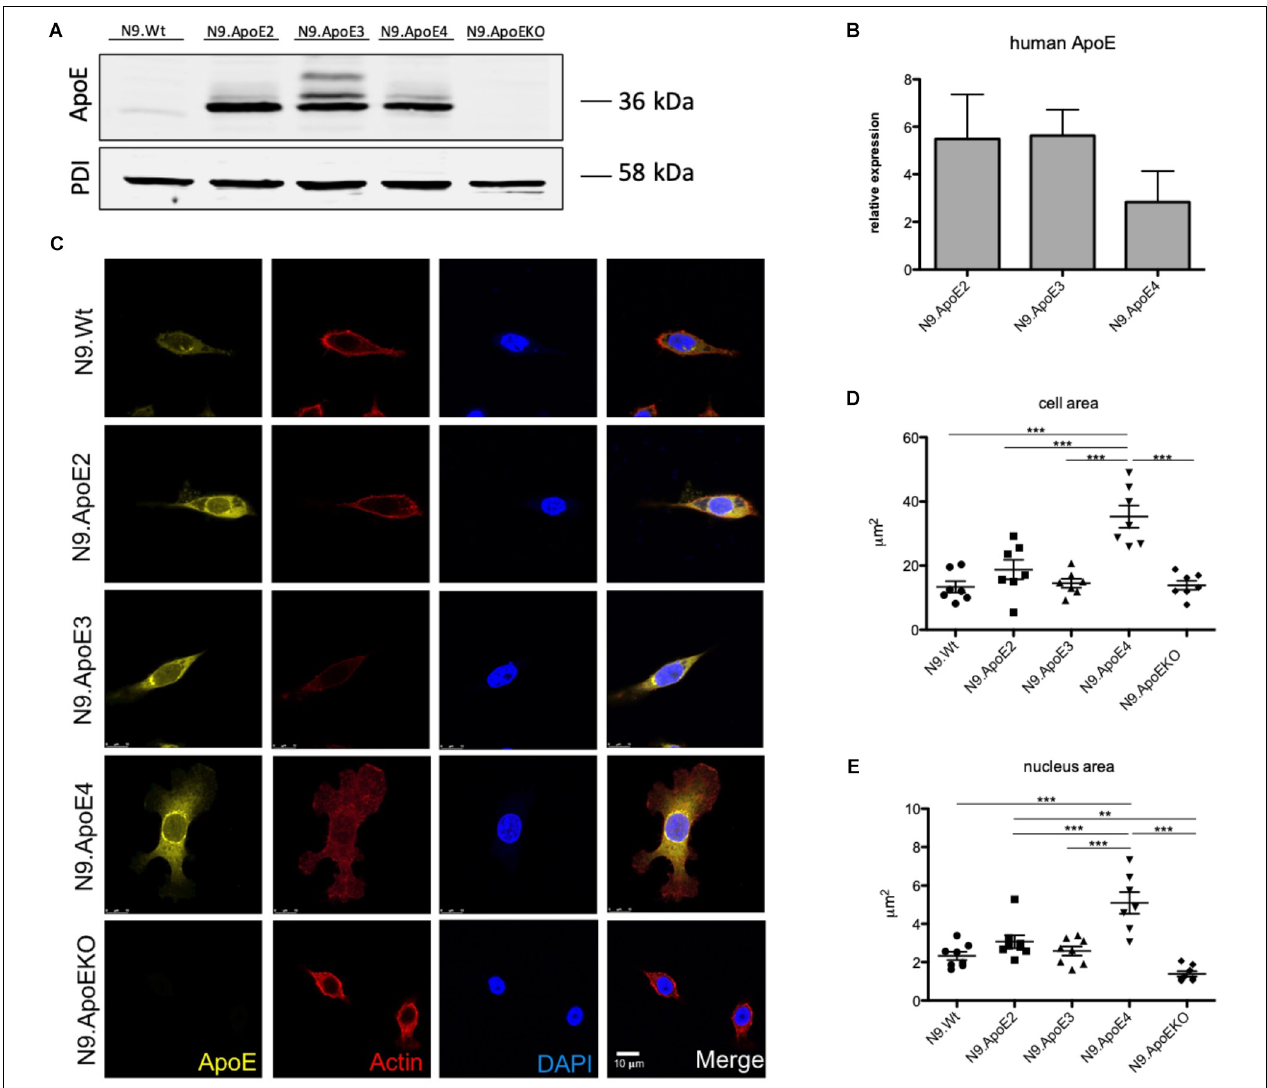
FIGURE 1 | Microglia morphology is changed upon ApoE4 expression. (A) Western Blot analysis of the expression of the three human ApoE isoforms in the microglial cell line N9. PDI displays protein loading. N9.ApoEKO shows no expression of ApoE ( n = 3). (B) qPCR analysis of human ApoE RNA-expression normalized against murine GapDH levels. Expression of human ApoE is only abundant in cells with human ApoE transduction and levels are comparable ( n = 3). (C) Representative pictures of immunofluorescent imaging show changes in morphology of N9.ApoE4 and N9.ApoEKO. N9.ApoE4 demonstrates a significant increase in cell area (D) , and nucleus size (E) , whereby N9.ApoEKO displays a decrease in both. Additionally, many of N9.ApoE4 cells are much larger in comparison to the cells of the other cell lines ( n = 7). Statistical significance was set up at ∗∗ p < 0.01 and ∗∗∗ p <